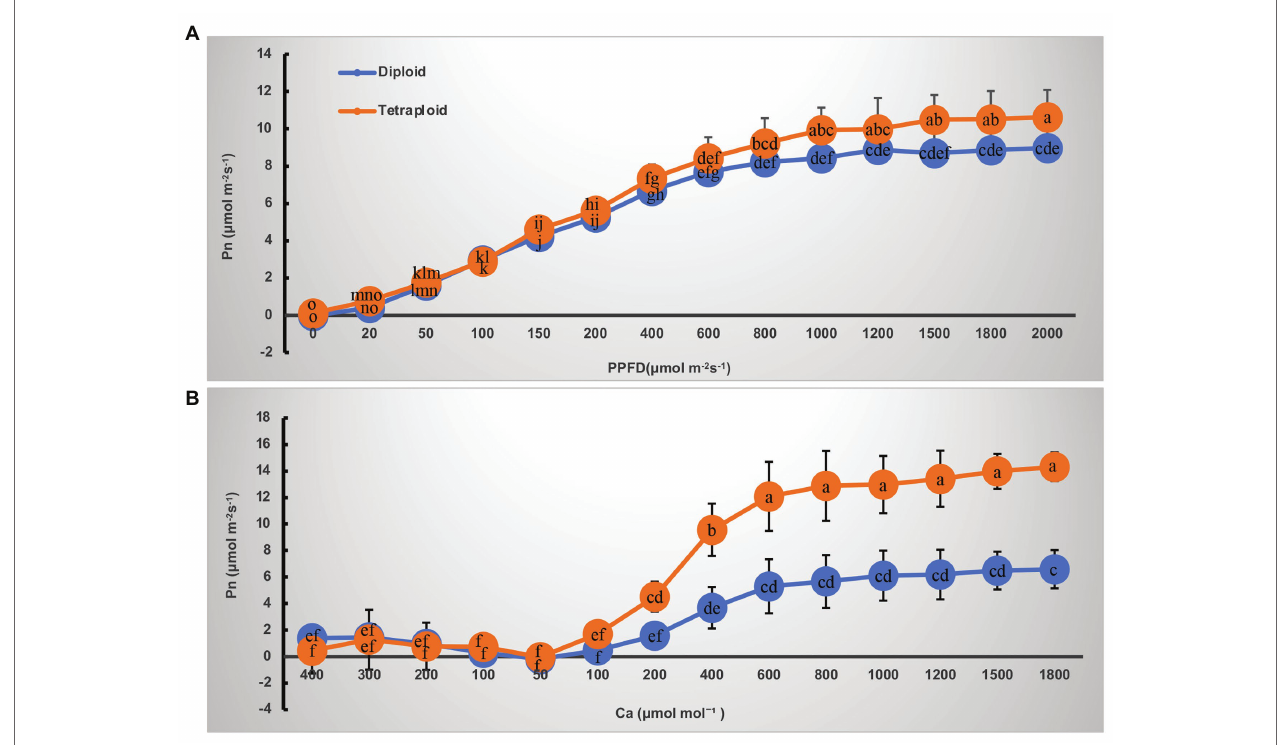
FIGURE 3 | Curves of net photosynthetic rate (Pn) response to irradiance and CO 2 in leaves of the diploid and tetraploid barley. (A) Response to photosynthetic photon flux density (PPFD). (B) Response to ambient CO 2 concentration (Ca). Different letters represent significant differences of Pn between diploid and tetraploid barley under varying supply of PPFD or Ca ( n = 10).